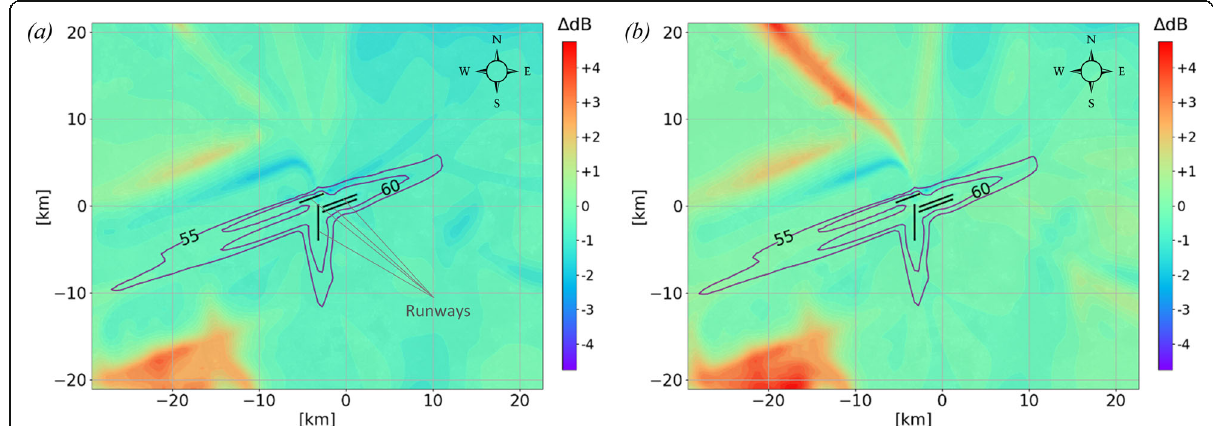
Fig. 6 Maps of predicted variations in L DEN at Frankfurt Airport from 2018 to 2025 ( Δ dB = L DEN,2025 – L DEN,2018 ). a Effect of fleet substitution, 2018 L DEN contours. b Effects of fleet substitution and traffic increase, 2025 L DEN contours